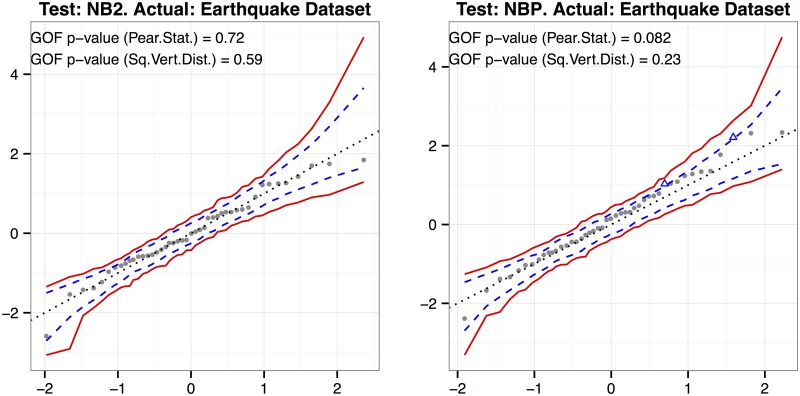
Empirical Probability Plots for Evaluating NB2 and NBP Model Fits.Empirical probability plots with GOF test p-values for evaluating NB2 and NBP model fits on the earthquake dataset (sample size: 45), with 95% prediction envelope in dashed blue lines and 95% simultaneous prediction band in solid red lines (based on 999 Monte Carlo simulations). Points outside the prediction envelope are flagged as blue triangles.